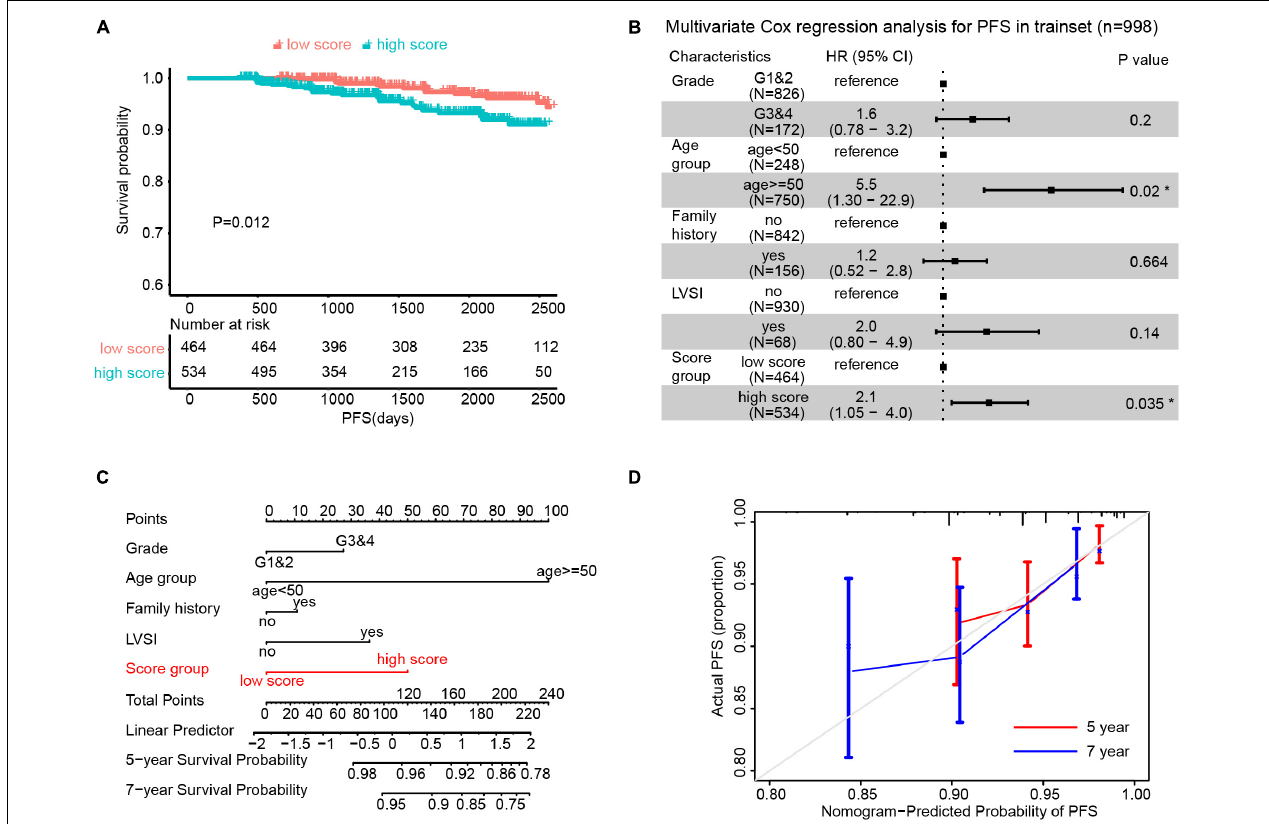
FIGURE 3 | Endometrial Cancer Prognostic-Related Metabolic (ECPRM) Score possessed the remarkable ability in predicting PFS in early-stage EEC. (A) The Kaplan-Meier survival analysis revealed the strong association between high ECPRM Score and shorter PFS in the trainset. (B) A forest plot of the multivariate Cox regression analysis showed that the high ECPRM Score was significantly associated with shorter PFS in the trainset. (C) A nomogram was built by integrating pathologic grade, age group, family history, LVSI, and score group, indicating the robust predicting ability of a high ECPRM Score. (D) A calibration plot for the nomogram was conducted based on the trainset, and the favorable agreements were shown between the actual and estimated probability of PFS in 5 and 7 years.